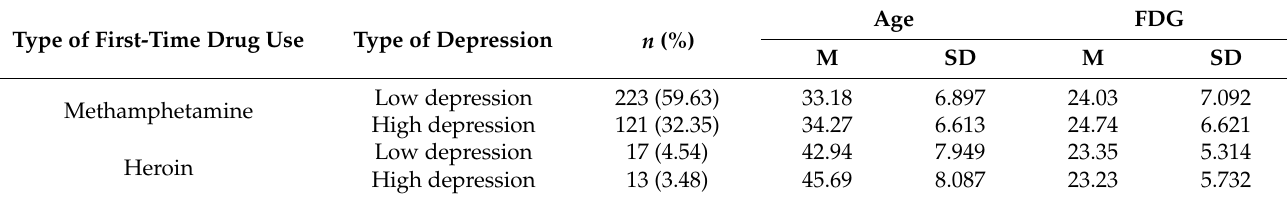
Table 3. Demographic information of participants ( n =